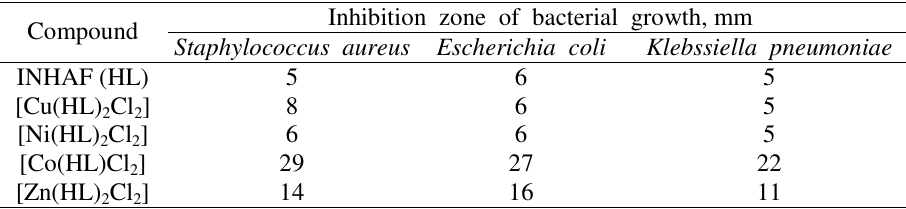
Table 4. Antimicrobial activity of INHAF and its metal